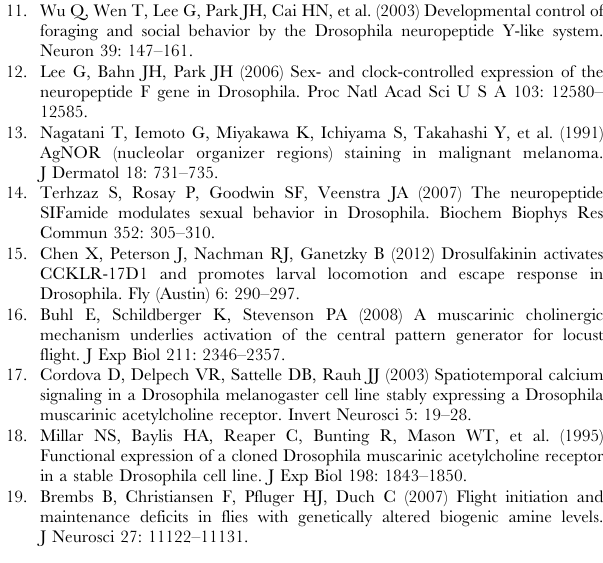
Table S1 List of GPCRs, and their respective RNAi lines tested in the primary screen, are shown, along with the percentage flight time observed upon pan-neuronal expression of each RNAi